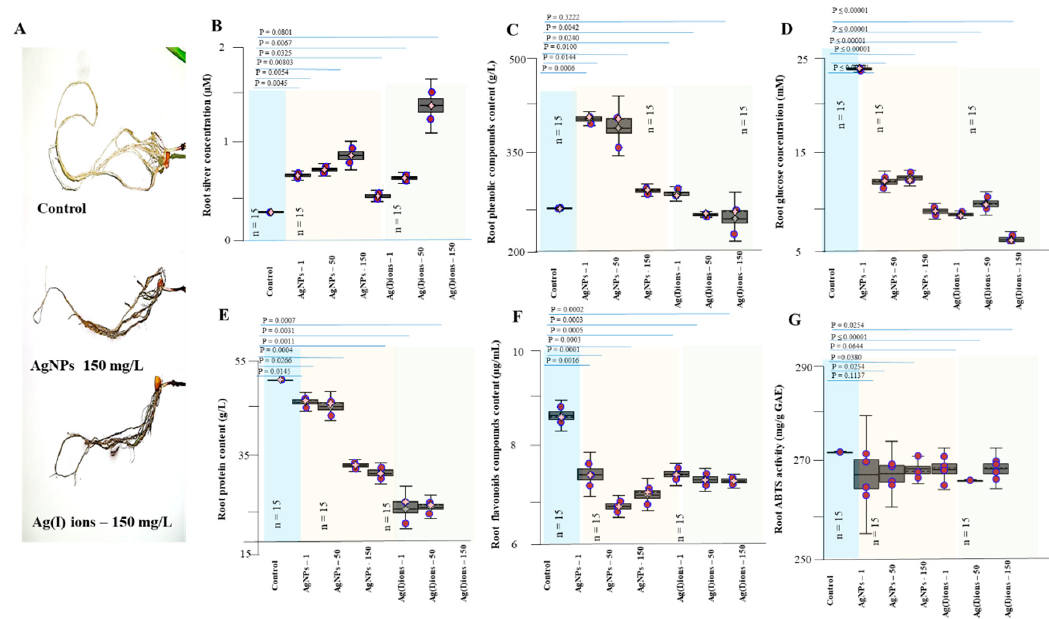
Figure 10. Influence of Ag(I) ions and AgNPs on the root system of seedlings. ( A ) A typical root system appearance after exposure for 96 h. The amount of ( B ) silver ions, ( C ) phenolic compounds, ( D ) glucose, ( E ) total proteins, and ( F ) total flavonoids. ( G ) ABTS activity. Plants were collected after 96 h of exposure to hydroponics. Plants were collected in triplicate every day and then processed according to the procedure described in the Material and Methods section. Data are presented as the average of all experimental data.